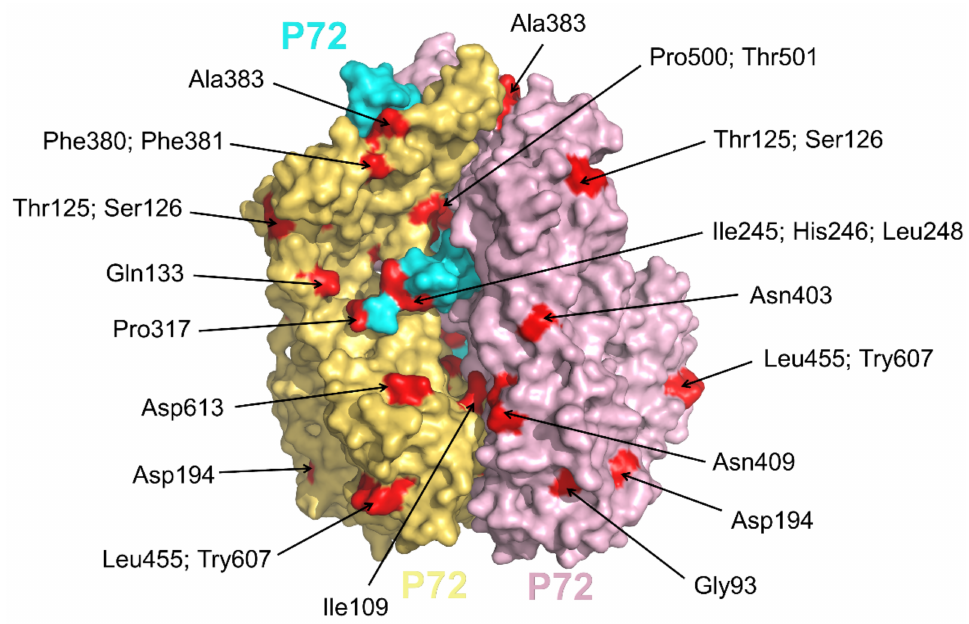
Figure 4. Location of mutations on the surface of p72 trimeric spike. Three subunits of p72 trimer (pdb: 6KU9) were shown in yellow-orange, cyan, and light-pink, respectively. All mutations of p72 were found by blasting all the full-length p72 at NCBI and were shown in